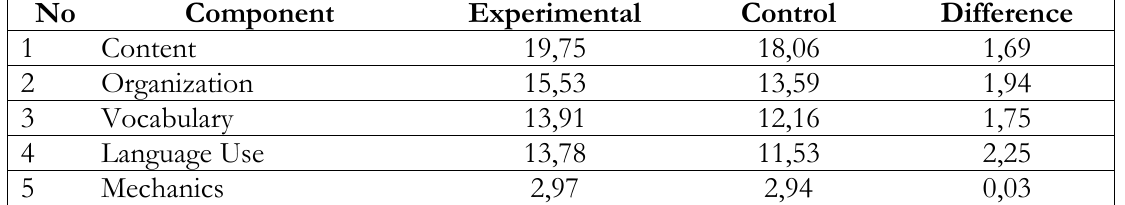
TABLE 4.3 The Score of Writing Test of Experimental Group and Control